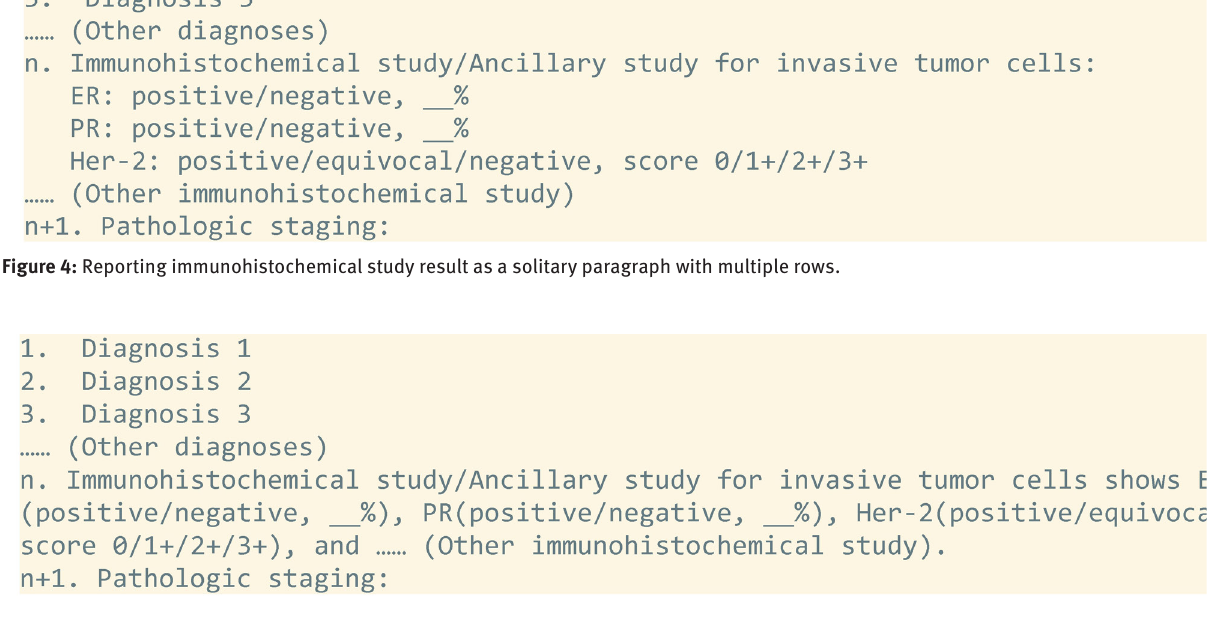
Figure 5: Reporting immunohistochemical study result as a solitary paragraph, with different studies separated by commas.